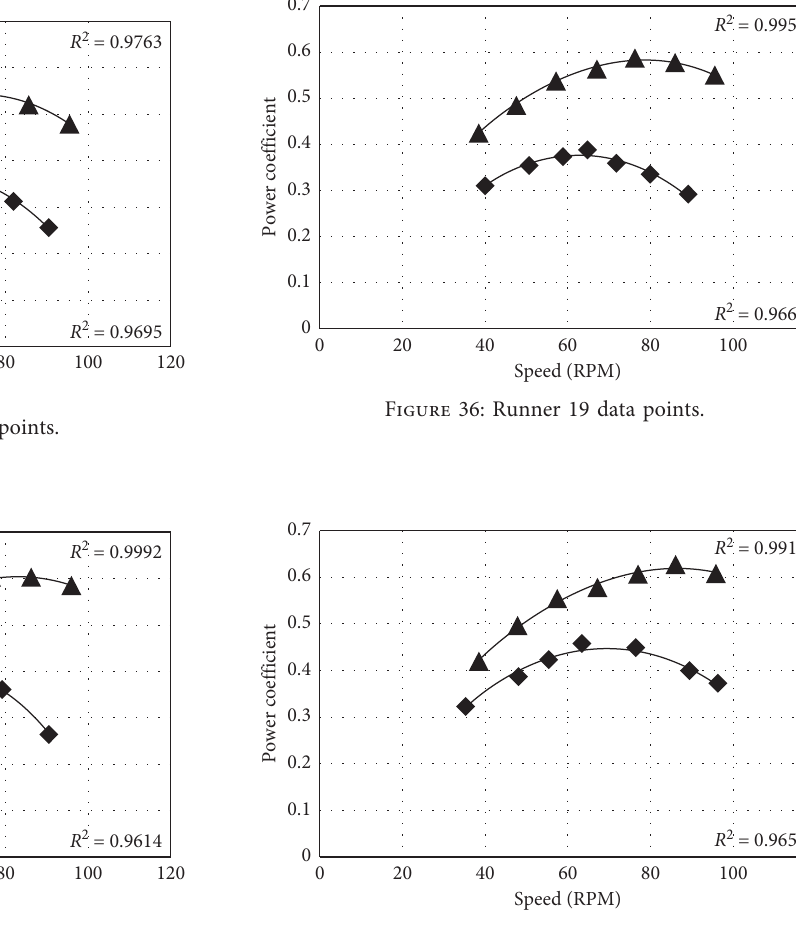
Figure 37: Runner 20 data points.